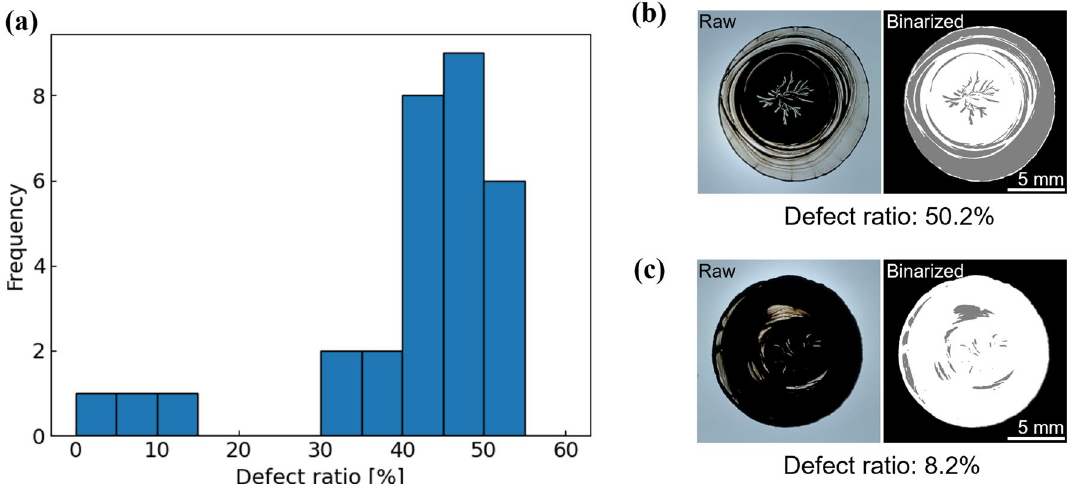
Figure 2. Results of the experiments under random parameters. ( a ) Distribution of the observed defect ratios and typical appearances of samples with ( b ) high defect ratio and ( c ) low defect ratio. In ( b ) and ( c ), the raw images are shown on the left side, and the images with the defect areas detected by binarization are shown on the right side (adapted with permission from ref. 48 Copyright (2021) the Electrochemical Society).